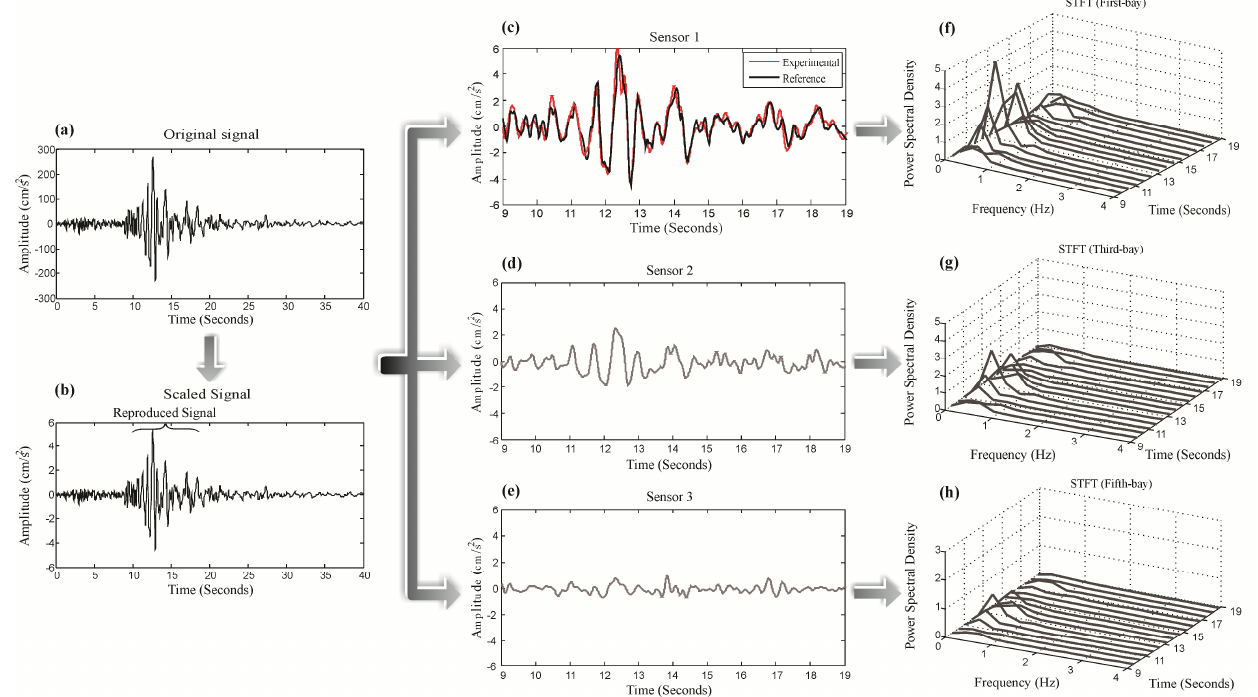
Figure 9. Earthquake in Loma Prieta, California 1989. 2 Fig. 9. Earthquake in Loma Prieta, California